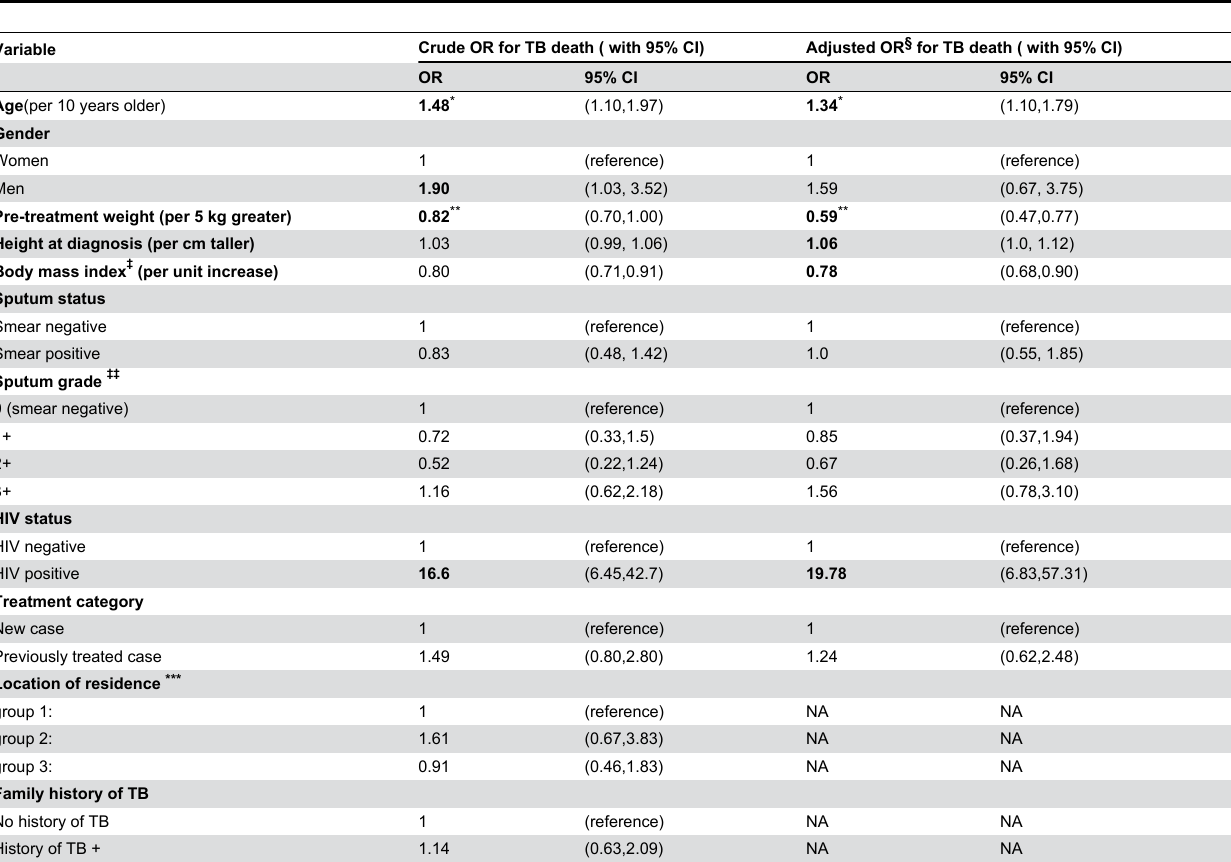
Table 4. Crude and adjusted estimates of covariates associated with TB related mortality.